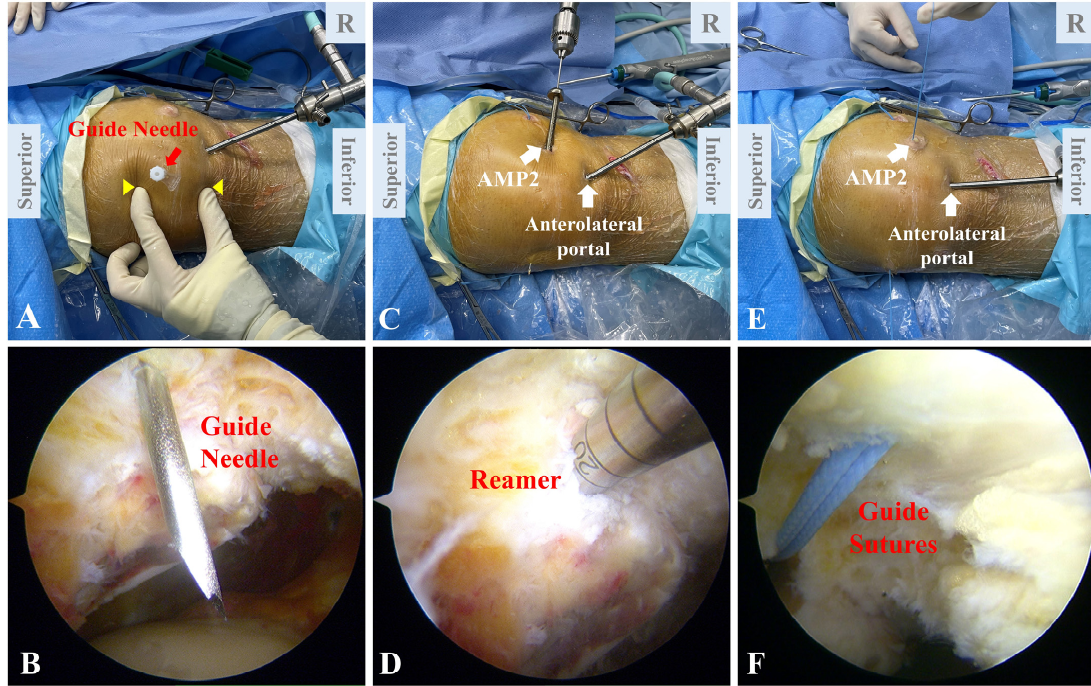
Figure 6. Positioning of patellar tunnel. ( A ) The superior pole, inferior pole (yellow triangles) and the medial margin of the patella are identified through palpation. A guide needle (red arrow) is inserted into the knee joint at the upper-third point of the medial patellar margin. ( B ) Arthroscopic view of the guide needle. ( C ) The arthroscope is placed through the anterolateral portal. A Kirschner wire is introduced through the AMP2 and penetrates the patella. ( D ) A reamer is used to drill the patellar tunnel. ( E ) Guide sutures are passed through the tunnel. ( F ) Arthroscopic view of the guide sutures. AMP, auxiliary medial portal.